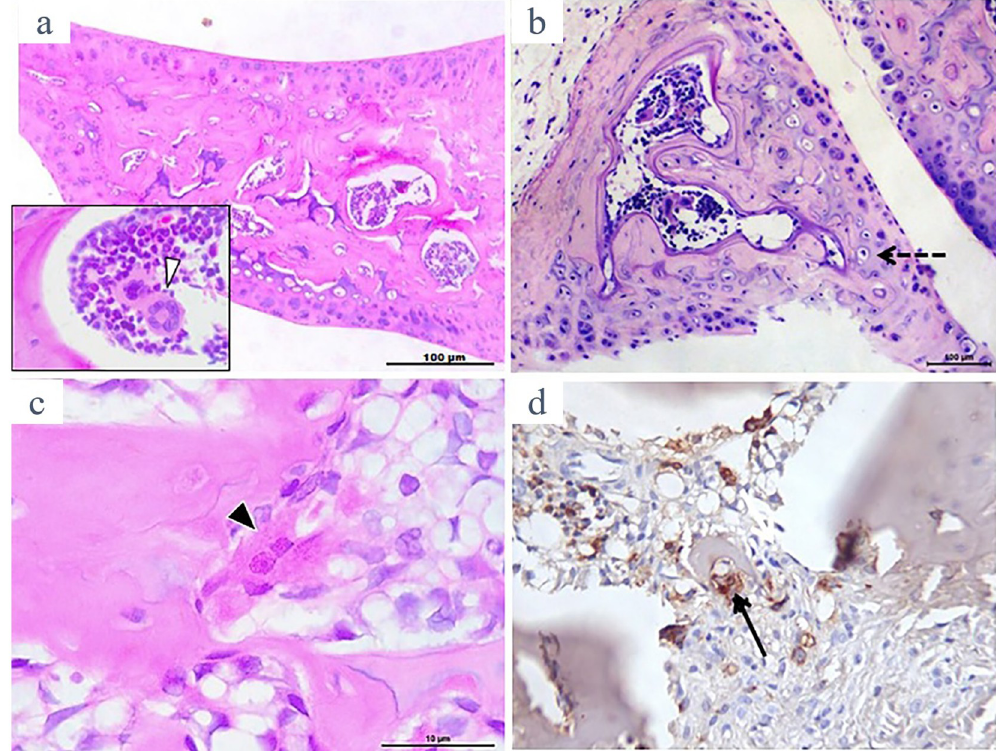
Fig 1. Representative illustration of H&E stained rat and mouse menisci showing calcified matrix with bone marrow spaces inside (a and b, respectively; original x 100). Inset in “a” shows a multilobed large megakaryocyte (white arrow-head; original x 1000). Inset in “b” shows a “buried” osteocyte with its surrounding lacunar space (dashed arrow). A rat meniscus sample showing an apparently active osteoclast is depicted in “c” (black arrow-head; original x 1000) and various tartrate- resistant acid phosphatase (TRAP) + stained cells indicating active, bone-resorbing multinucleated osteoclasts are shown in “d” (black arrow; original x 400).